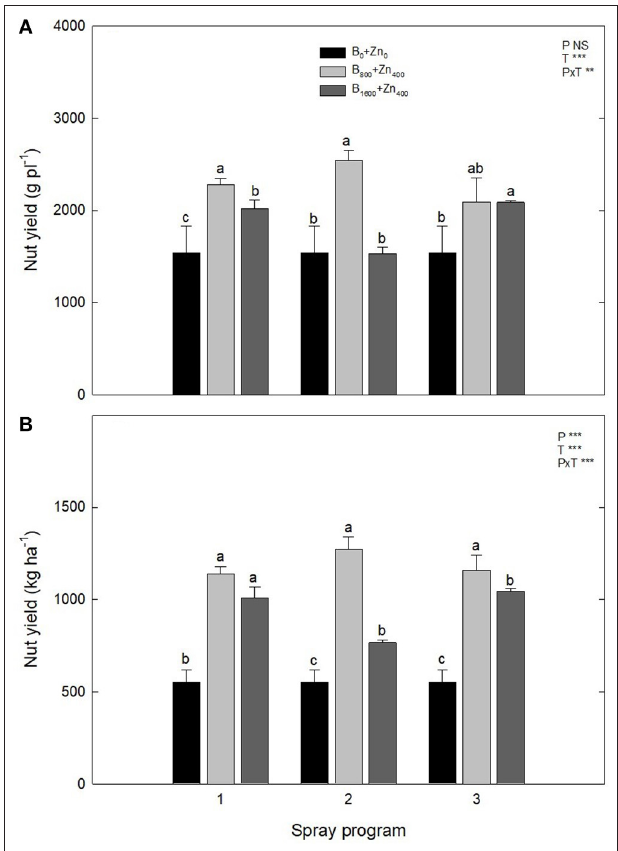
FIGURE 4 | Effects of applied spraying programs on stabilized fruit yield per plant (g pl − 1 ) (A) and per hectare (kg ha − 1 ) (B) . Values represent the mean ( n = 3) ± SE. Different lowercase letters indicate statistically significant differences ( P ≤ 0.05) among treatments within each spray program. Two-way ANOVA results are shown (NS, not significant, P > 0.05; ** P < 0.01; *** P <